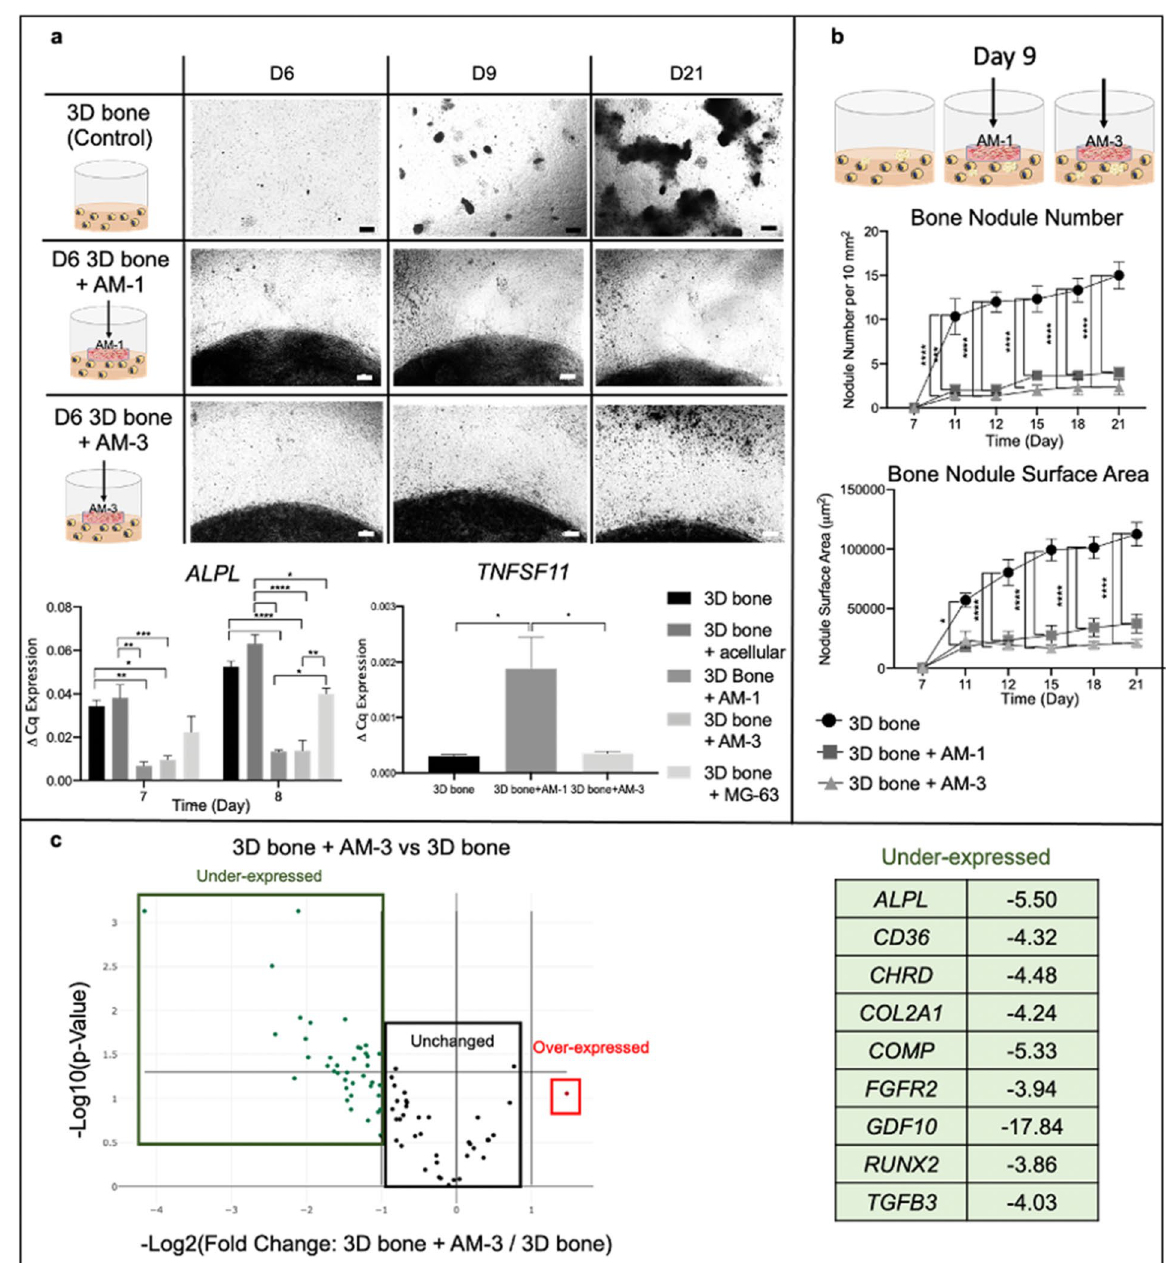
Figure 5. Introduction of ameloblastoma tumour mass to the 3D bone stroma prior to day 9 completely inhibits bone nodule formation. (a) Introduction of AM-1 and AM-3 tumour masses to 3D bone at day 6 inhibits bone nodule formation. Images taken at day 6, 9 and 21, 4 × Magnification, scale bar = 100 μm. ALPL expression. TNFSF11 (RANKL) Expression. ( b) Introduction of AM-1 and AM-3 tumour masses to 3D bone at day 9 restricts bone formation by limiting bone nodule number and bone nodule surface area. (c) RT2 Profiler PCR Array was conducted to screen osteogenesis gene of osteoblasts in the 3D bone stroma model and in AM-3 tumour mass introduced 3D bone stroma model at day 8. The AM-3 tumour mass was introduced at day 6 of 3D bone stroma model. Volcano plot shows under-expressed, unchanged and over-expressed genes. The table represents > 3.5-fold under-expressed gene. Horizontal line p-value threshold (0.05). One-Way ANOVA, Dunnet’s Post Hoc; p-values 0.05 = *, 0.005 = **, 0.0005 = *** and 0.00005 =